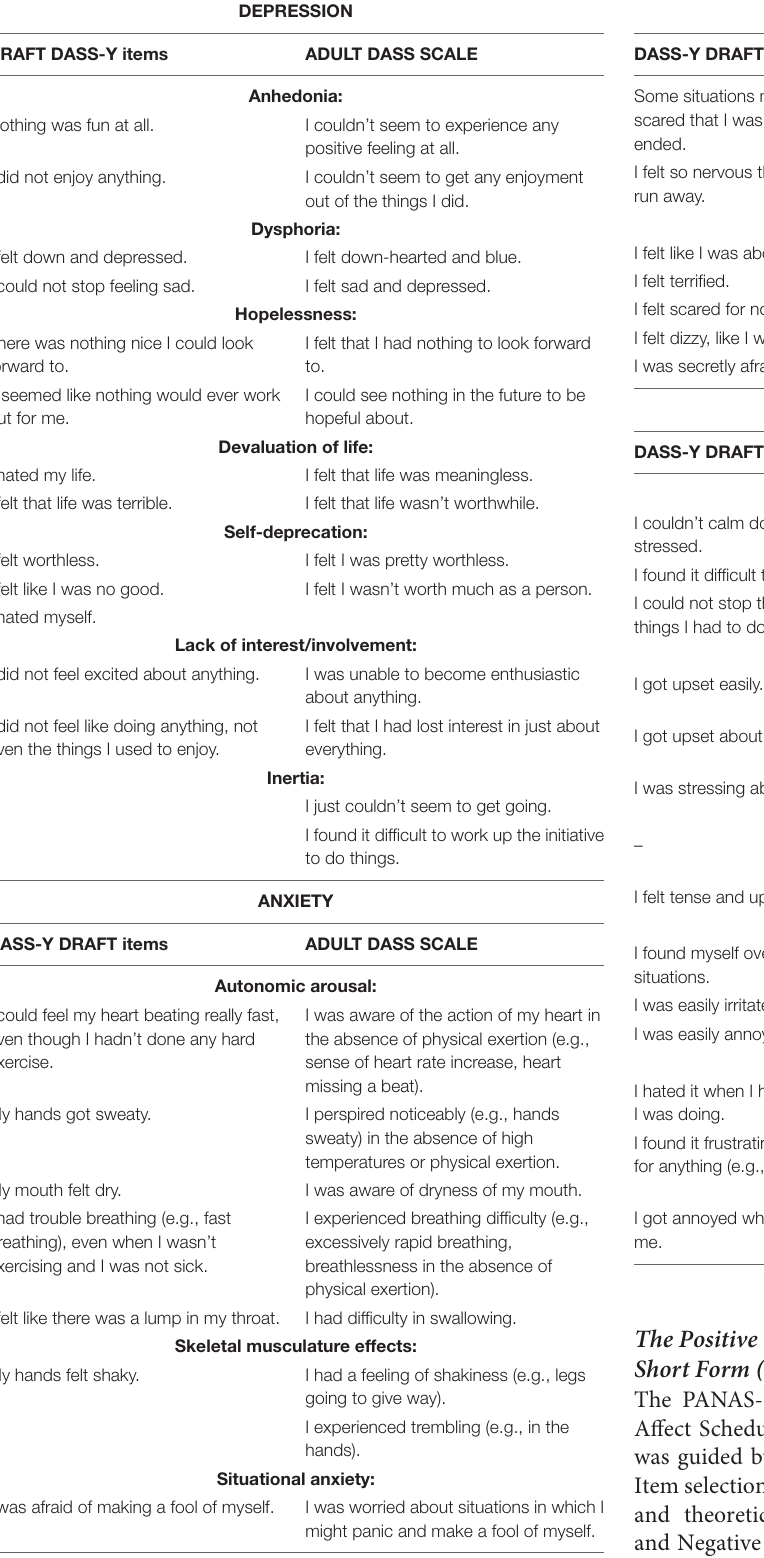
TABLE 2 | The 40 draft DASS-Y items and their adult DASS